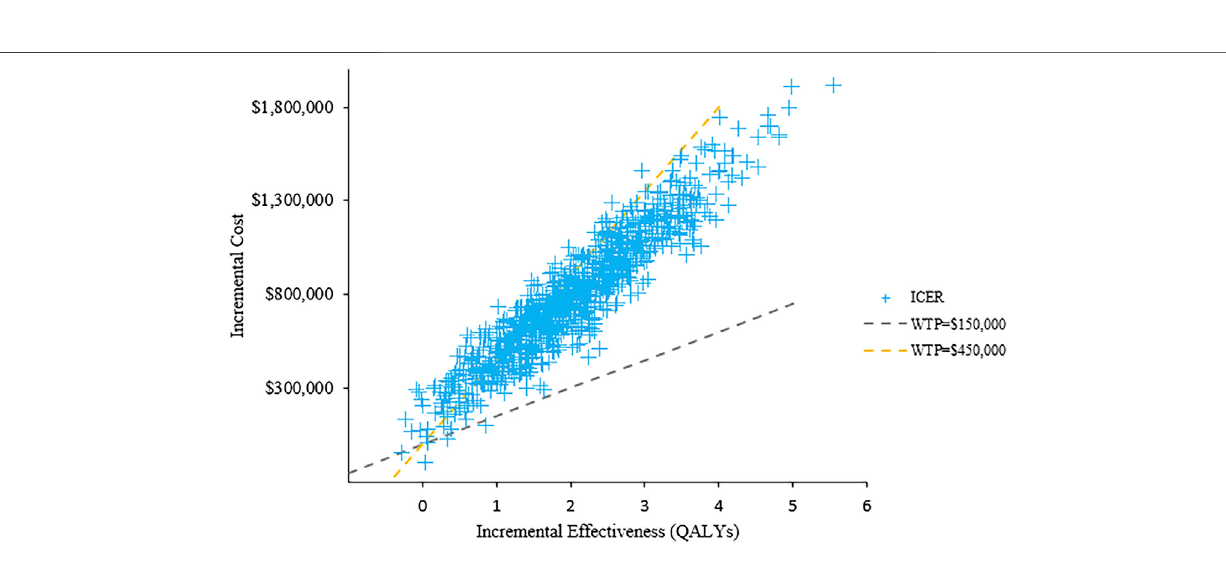
Frontiers in Pharmacology |